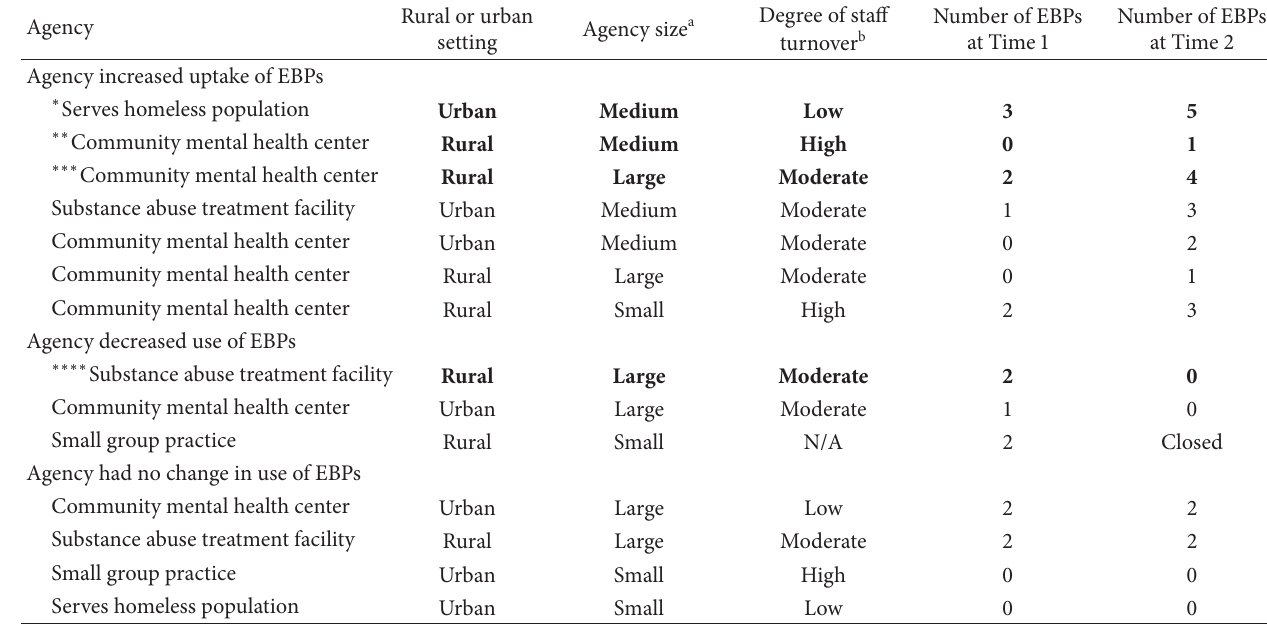
Table 3: Characteristics of